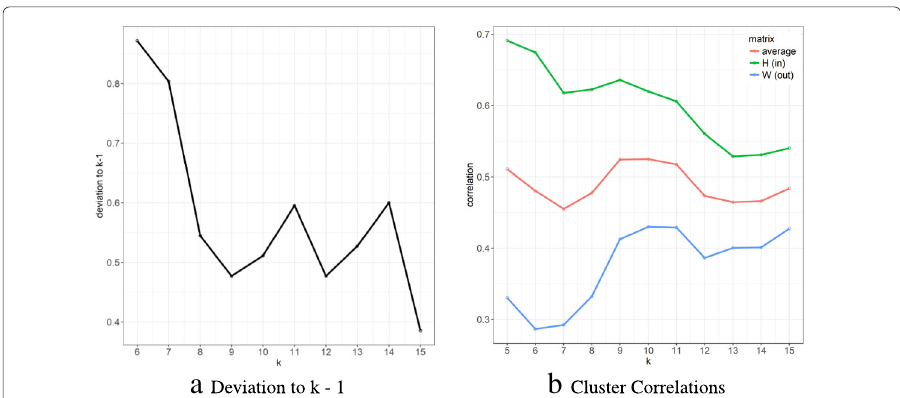
Fig. 4 Characteristics of the NMF decomposition of K for different numbers of clusters k . a Deviation to k - 1. b Correlation between w C ( c i , c j ) and ¯ w ( c − i , c − j